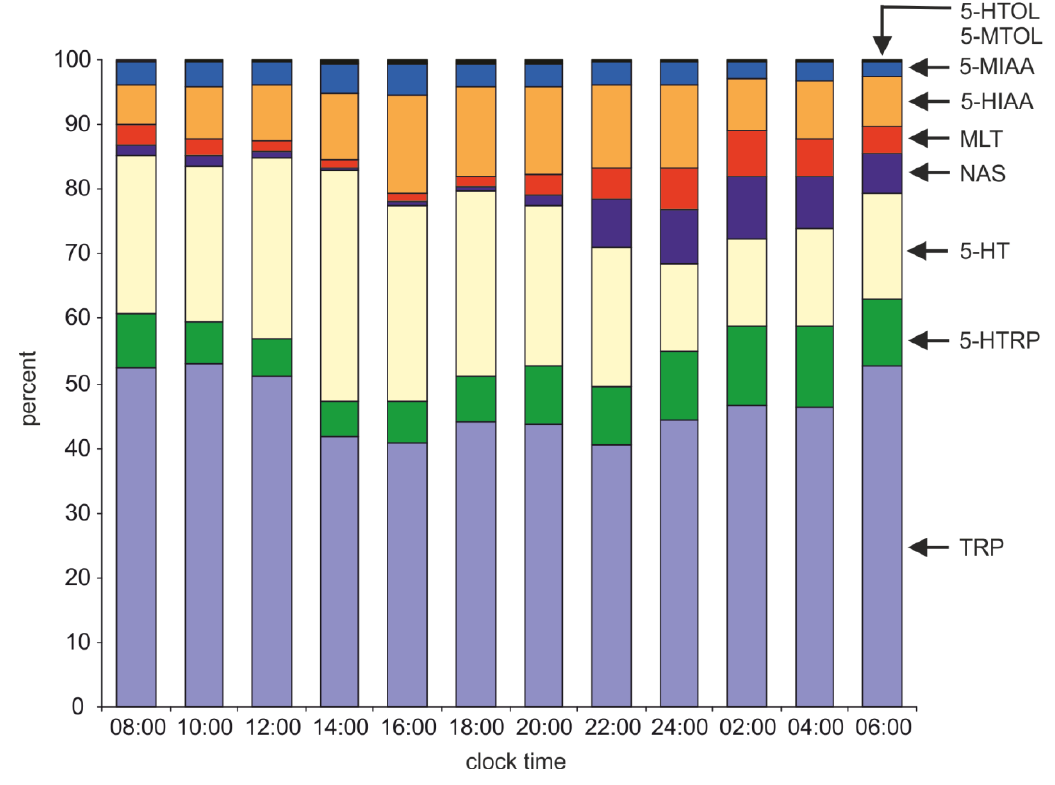
Figure 4. Percentage of indolic compounds measured in duck pineal organs taken at two-hour intervals over a daily cycle. The diagram demonstrates diurnal changes in the stoichiometric relationships between indoles (the input data are expressed as pmol/100 µg of